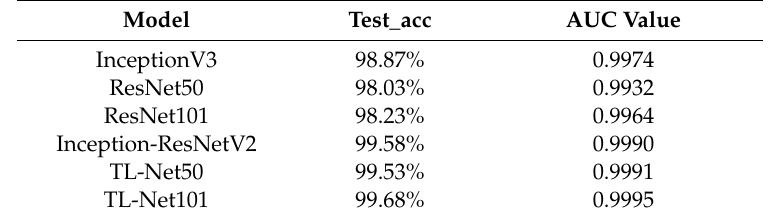
Figure 13. ( a ) The training accuracy curves of TL-Net101, InceptionV3, and Inception-ResNetV2; ( b ) the training loss curves of TL-Net101, InceptionV3, and Inception-ResNetV2 .